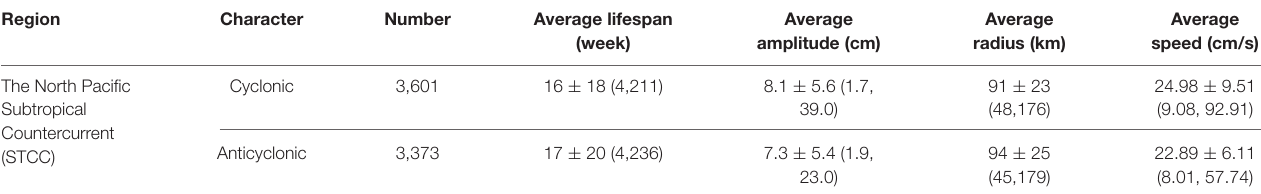
TABLE 1 | Statistics of mesoscale eddies in the STCC from 1993 to 2018.